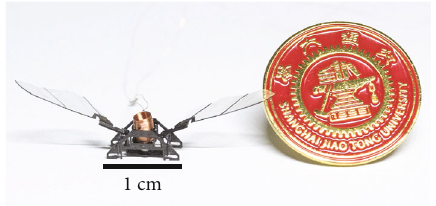
Figure 1: The sub-100mg insect-inspired fl apping-wing robot used as the prototype in this